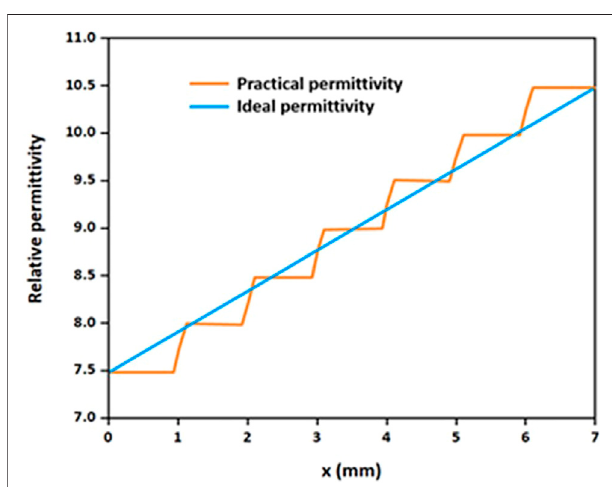
FIGURE 3 | Dielectric permittivity distributions.